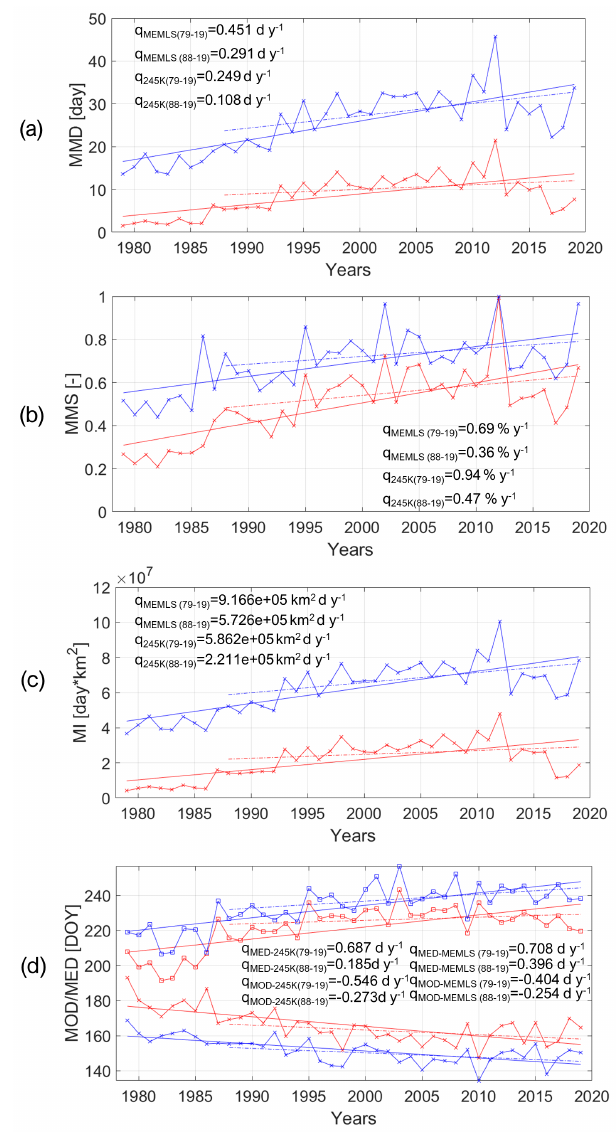
Figure 9. Time series of annual (a) mean melt duration (MMD), (b) maximum melting surface fraction (MMS, expressed as frac- tion of the surface area of the ice sheet), (c) melt index (MI), and (d) melt onset date (MOD) and melt end date (MED). Regres- sion lines were computed for the 1979–2019 (solid line) and 1988– 2019 (dot-dashed line) periods. The MMD is averaged over all of the Greenland ice sheet pixels. Red (blue) lines refer to the 245K (MEMLS) algorithm; in panel (d) , squares (crosses) refer to MED